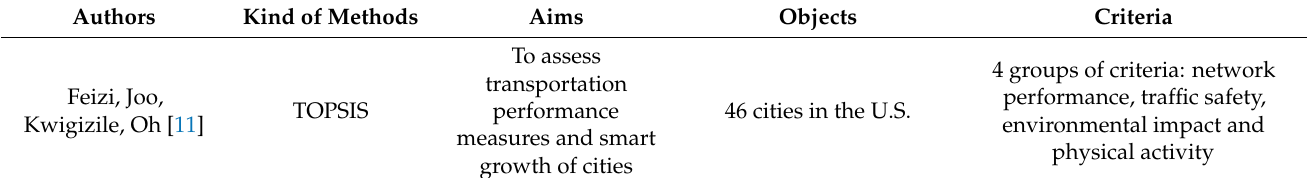
Table 1. Papers relevant to MCDM and urban